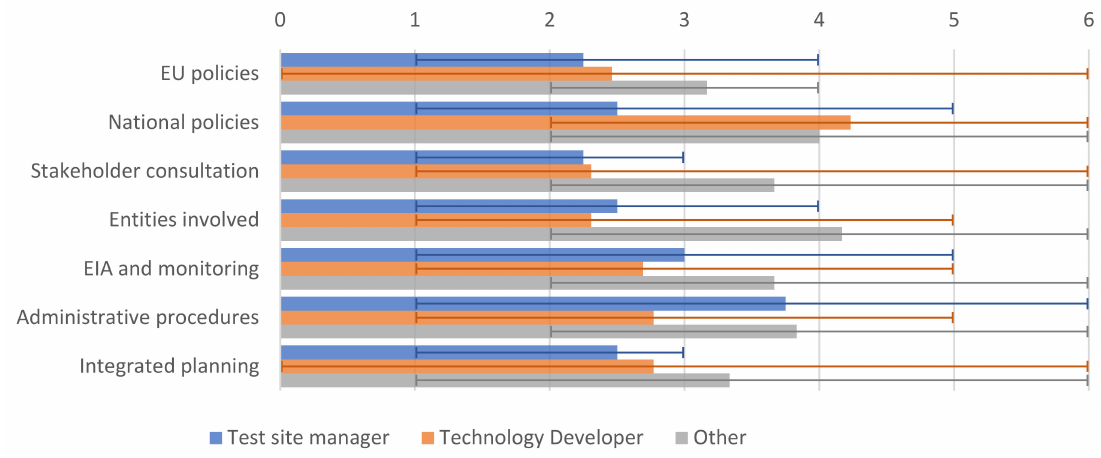
Figure 4. Overview on respondents’ perceptions. Shaded bars show mean result; error bars show range of responses. (0: no barrier/enabler; 6: significant